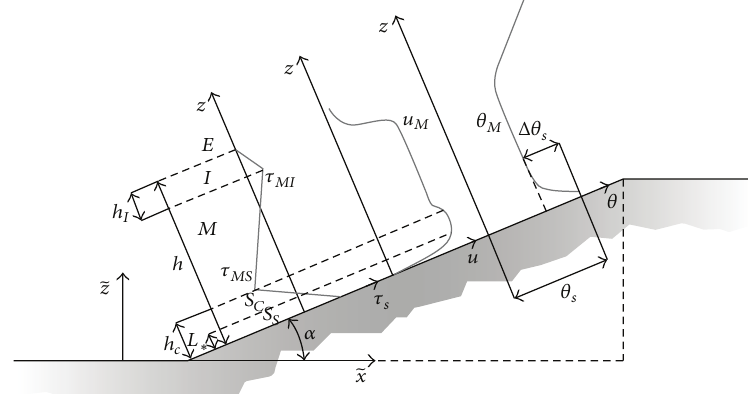
Figure 23: Schematic of the model proposed by Hunt [65] and Hunt et al. [7] for the investigation of anabatic